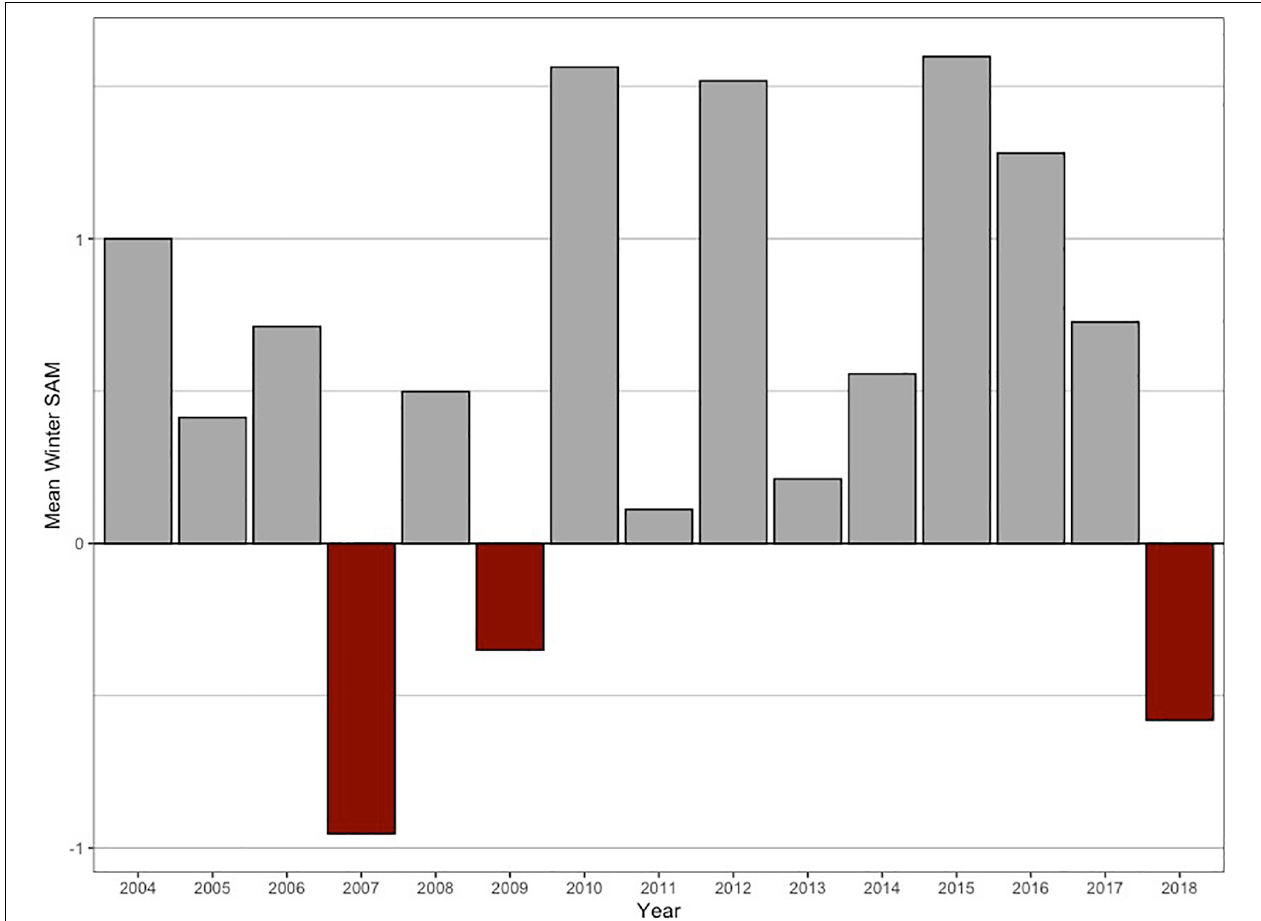
FIGURE 4 | Mean winter SAM index during the study period (2004–2018). For the mean winter foraging phase (March–August), the SAM index was mostly in its positive phase (136 tags deployed), with 2007, 2009, and 2018 contributing to the negative SAM years (47 tags